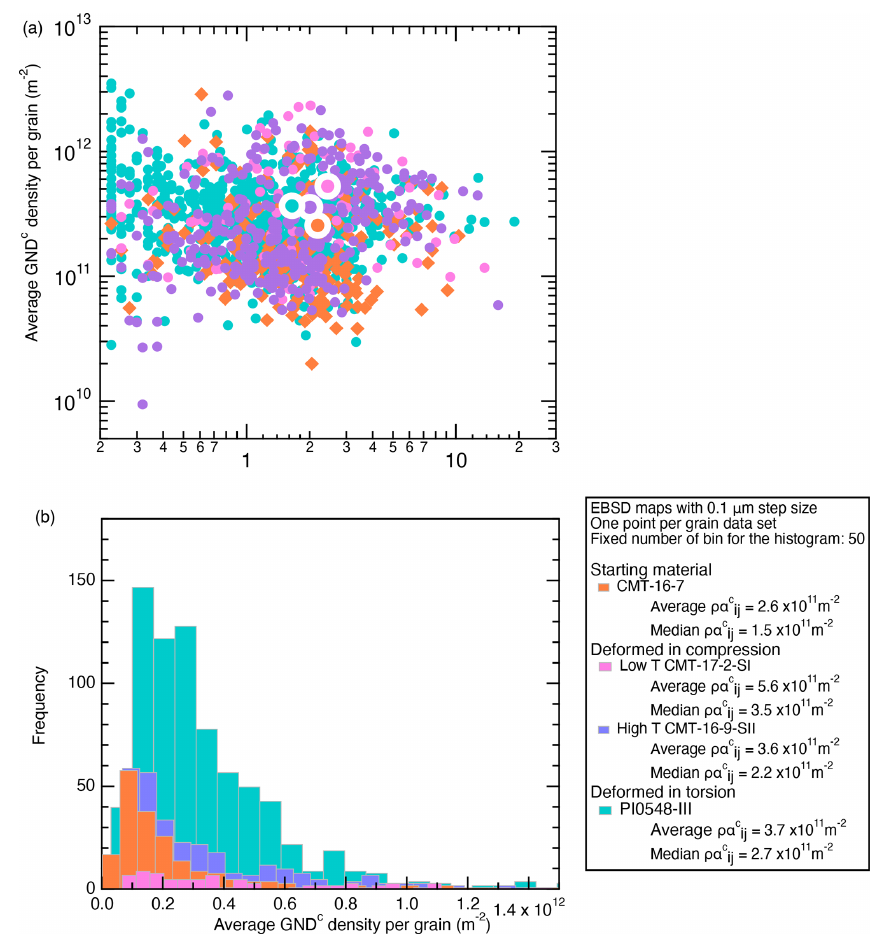
Figure 10. (a) Representative distribution of GND density (one point per grain) as a function of the grain size in the starting material (CMT- 16-7), in two samples deformed in axial compression (at low temperature for CMT-17-2 and at high temperature for CMT-16-9-SII) and in a sample deformed in torsion (PI0546-III). The step size was 0.1µm (original acquisition step size). Also shown is the average GND density for each sample as a large symbol; (b) same samples as in (a) with a histogram of GND density (one point per grain) showing a distribution close to lognormal, with the median values then representing the distribution more accurately than the average